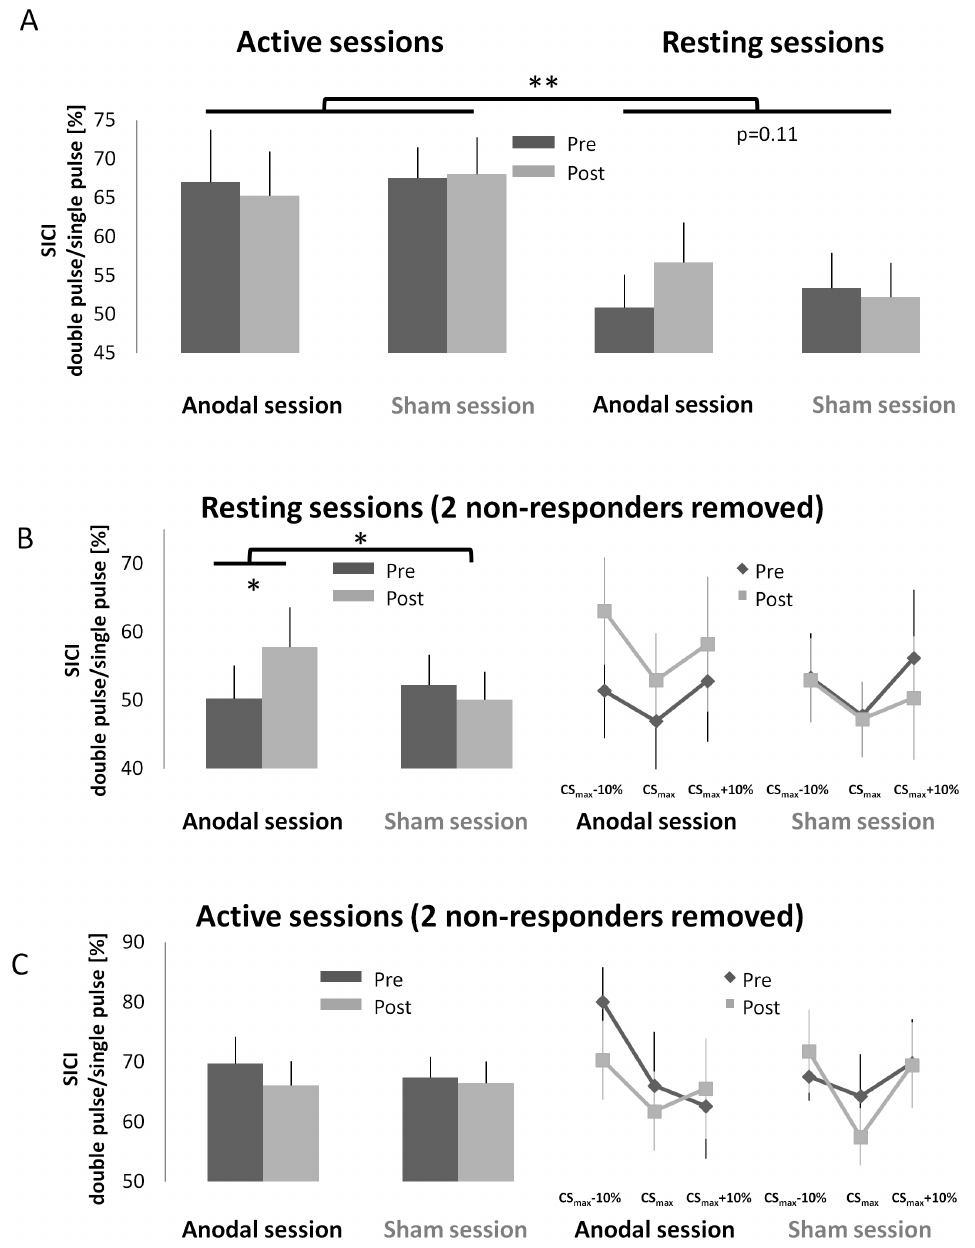
Figure 4. Intracortical inhibition (SICI) results. A: There was a significant decrease in SICI in the active motor state compared to the resting motor state (p=0.004). There was a trend towards a reduction in SICI following anodal tDCS when non-responders were included in the analysis (p=0.11). B: Mean SICI data and SICI curve from the resting sessions are shown when the 2 non-responders were removed from the analysis. The left panel shows the significant interaction between the anodal and sham sessions (p=0.04). Post-hoc test revealed that SICI was significantly reduced in the anodal session (p=0.027), but not the sham session (p=0.478). The right panel shows the full SICI curves. C: Mean SICI data and SICI curve from the active sessions are shown when the 2 non-responders were removed from the analysis. There were no significant changes in either mean SICI data or SICI curve. Error bars represent mean 6 SEM. * p , 0.05; ** p , 0.01.